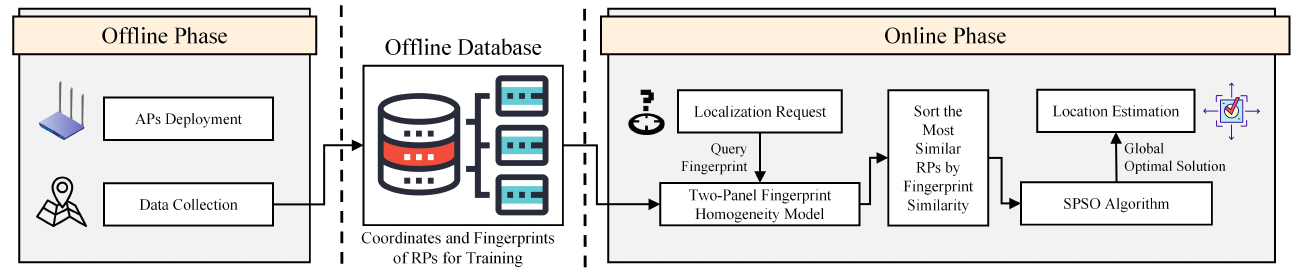
Figure 1. Schematic of the localization